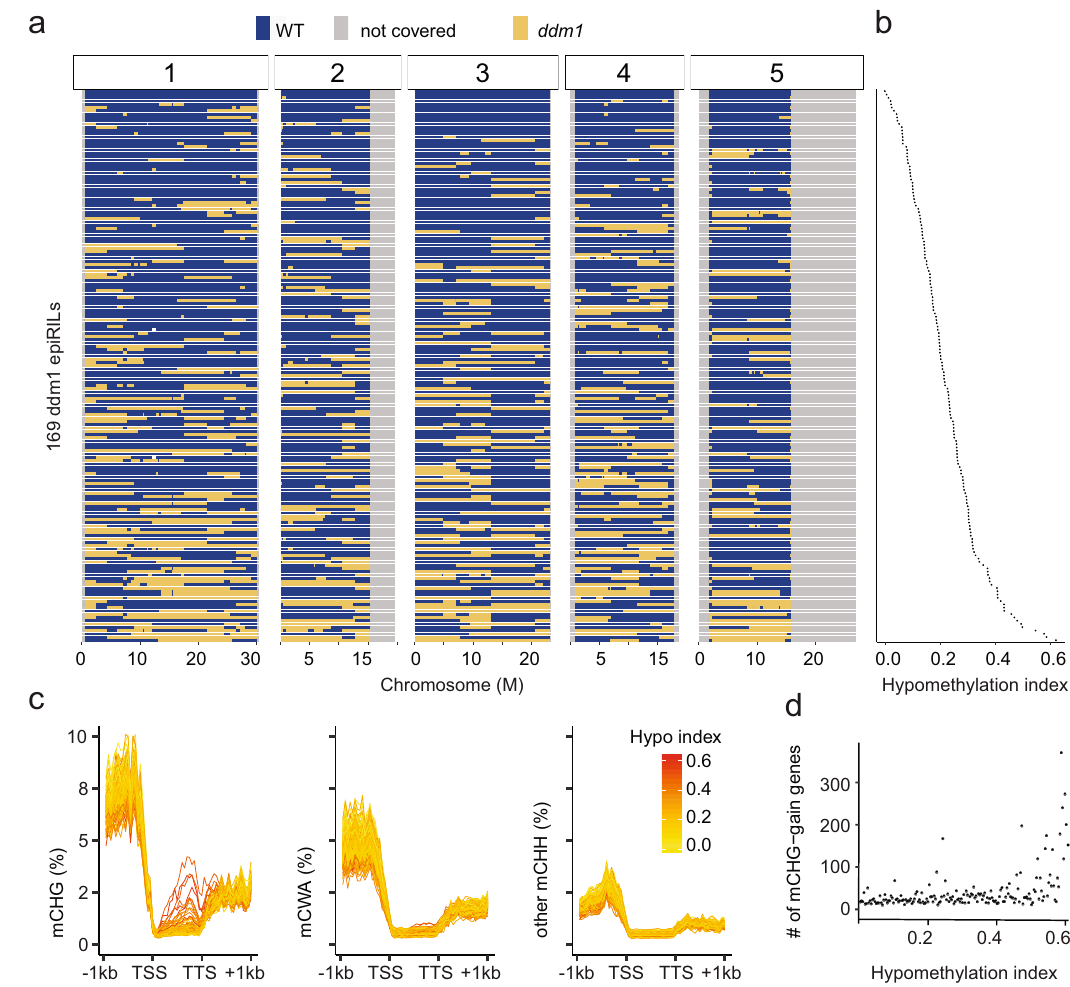
Fig. 2 Hypomethylated chromosomes from the ddm1 parent lead to ectopic DNA methylation in gbM genes. a A haplotype map for 169 ddm1 epiRIL lines. Each row represents the genome composition of one epiRIL line which was ordered based on hypomethylation index which indicates amounts of DNA inherited from the ddm1 parent. Yellow bars represent regions from ddm1 parent, blue bars represent regions from wild-type parent and gray bars show regions not covered by markers. b Hypomethylation index is calculated as an average of the values on 144 DMR markers (methylated WT marker = 0, unmethylated ddm1 marker = 1). So higher the value represents a more hypomethylated genome. c Metaplot shows non-CG methylation pattern on gbM genes for 169 ddm1 epiRIL lines. Methylation patterns for each sample is shown by one line that was colored based on its hypomethylation index. d The scatter plot indicates the number of gbM genes that gain CHG methylation for each sample. Source data underlying Figs. 2a, 2c, and 2d are provided as a Source Data fi CG methylation is lost. Therefore, using these lines we can compare genes that maintain gbM versus those that were once gbM, but are now UM due to inheritance via met1 .